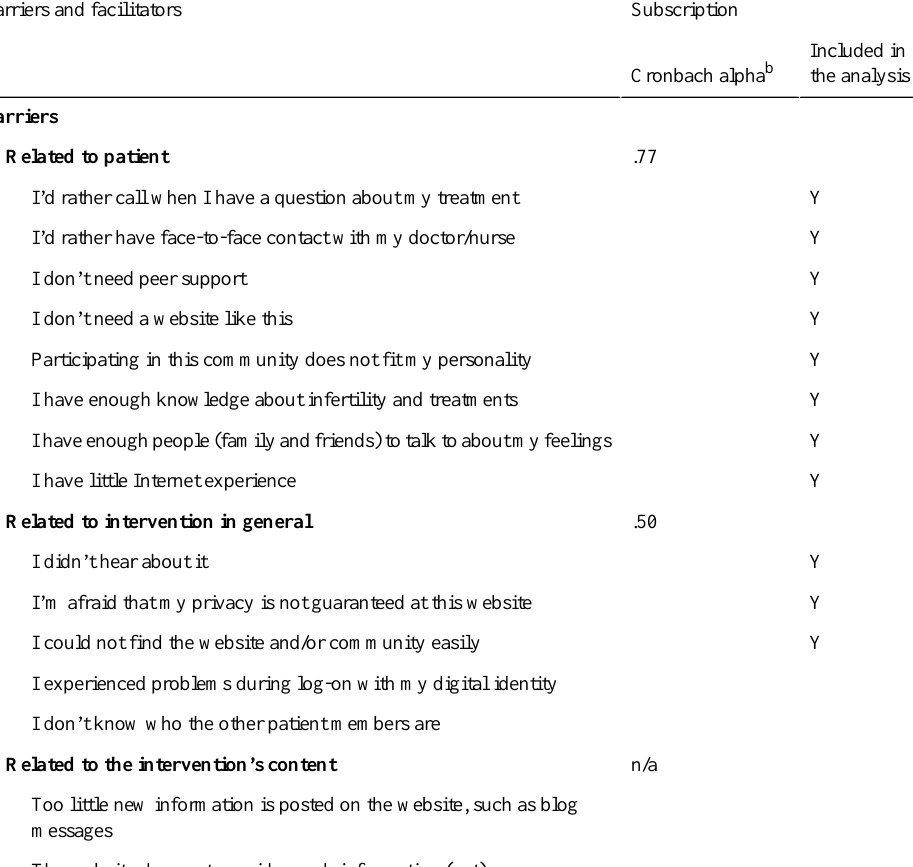
Table 1. Barriers and facilitators into domains a resulting from the qualitative